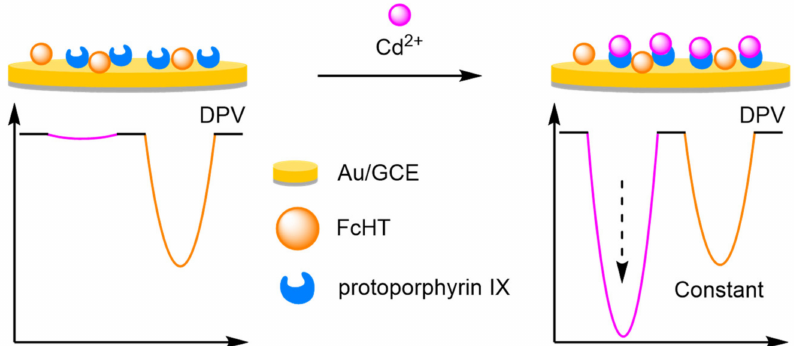
Figure 27. Schematic representation of a modified electrode for the detection of Cd 2+ .